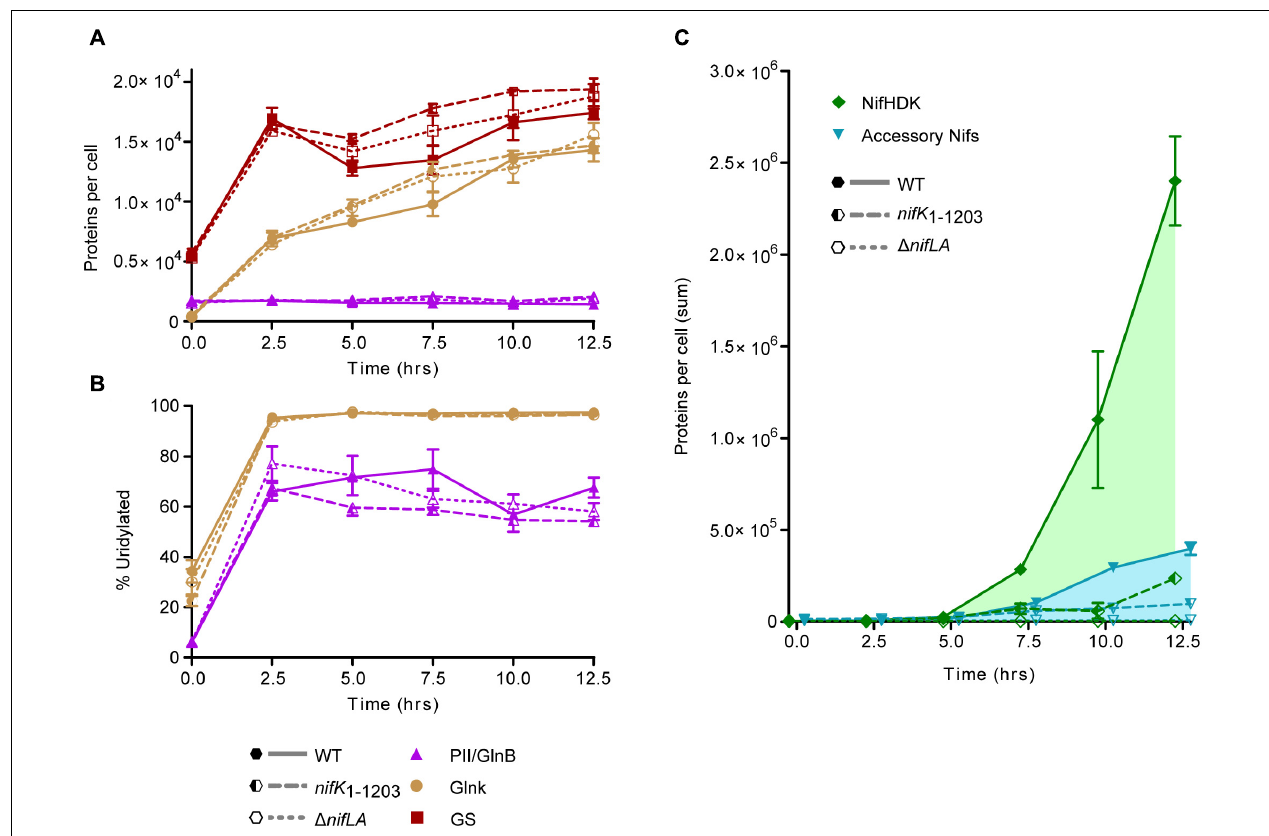
FIGURE 5 | Time-course of Nif and Ntr protein expression and post-translational N stress signaling. Ko M5a1 wild-type (full lines, full shapes) nifK 1 − 1203 (dashed lines, half shapes) and (cid:49) nifLA (dotted lines, empty shapes) strains were cultured for 12.5 h in NFDM medium supplemented with 0.5 mM NH 4 Cl under micro-aerobic conditions. Cell protein was extracted at 2.5 h intervals, supplemented with a mix of four QconCAT standards and trypsin digested. Absolute copy number was inferred from the sample/QconCAT LC–MS peak area ratio for quantotypic non-modifiable peptides and QconCAT concentration, assuming an OD600 of 1.0 = 10 9 CFU mL − 1 and a cell volume of 10 − 15 L. Error bars represent SEM of three biological replicates. (A) Copy number of Ntr proteins: GlnB (purple), GlnK (brown), and glutamine synthetase (GS) (orange). (B) Post-translational modification of PII-type proteins GlnB and GlnK. Percentage uridylylation was inferred from the modified/total LC–MS peak area ratio for modifiable peptides. (C) Summed absolute copy numbers of nitrogenase subunits NifHDK (green) and accessory proteins associated with co-factor biosynthesis and assembly (blue). Overlapping data points offset for